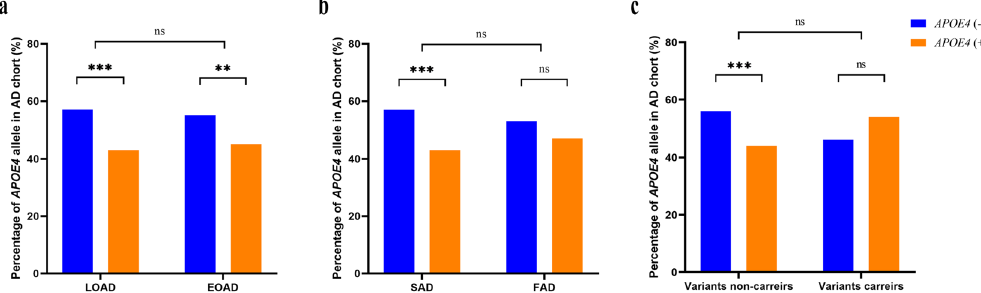
Fig. 4 The percentage of APOE4 in AD cohort. a The percentage of APOE4 in LOAD and EOAD. b The percentage of APOE4 in SAD and FAD. c The percentage of APOE4 in AD patients with and without P/LP variants. * p < 0.05, ** p < 0.01, *** p < 0.001, **** p < 0.0001, ns no signi fi cance. LOAD late-onset Alzheimer ’ s disease, EOAD early-onset Alzheimer ’ s disease, SAD sporadic Alzheimer ’ s disease, FAD familial Alzheimer ’ s